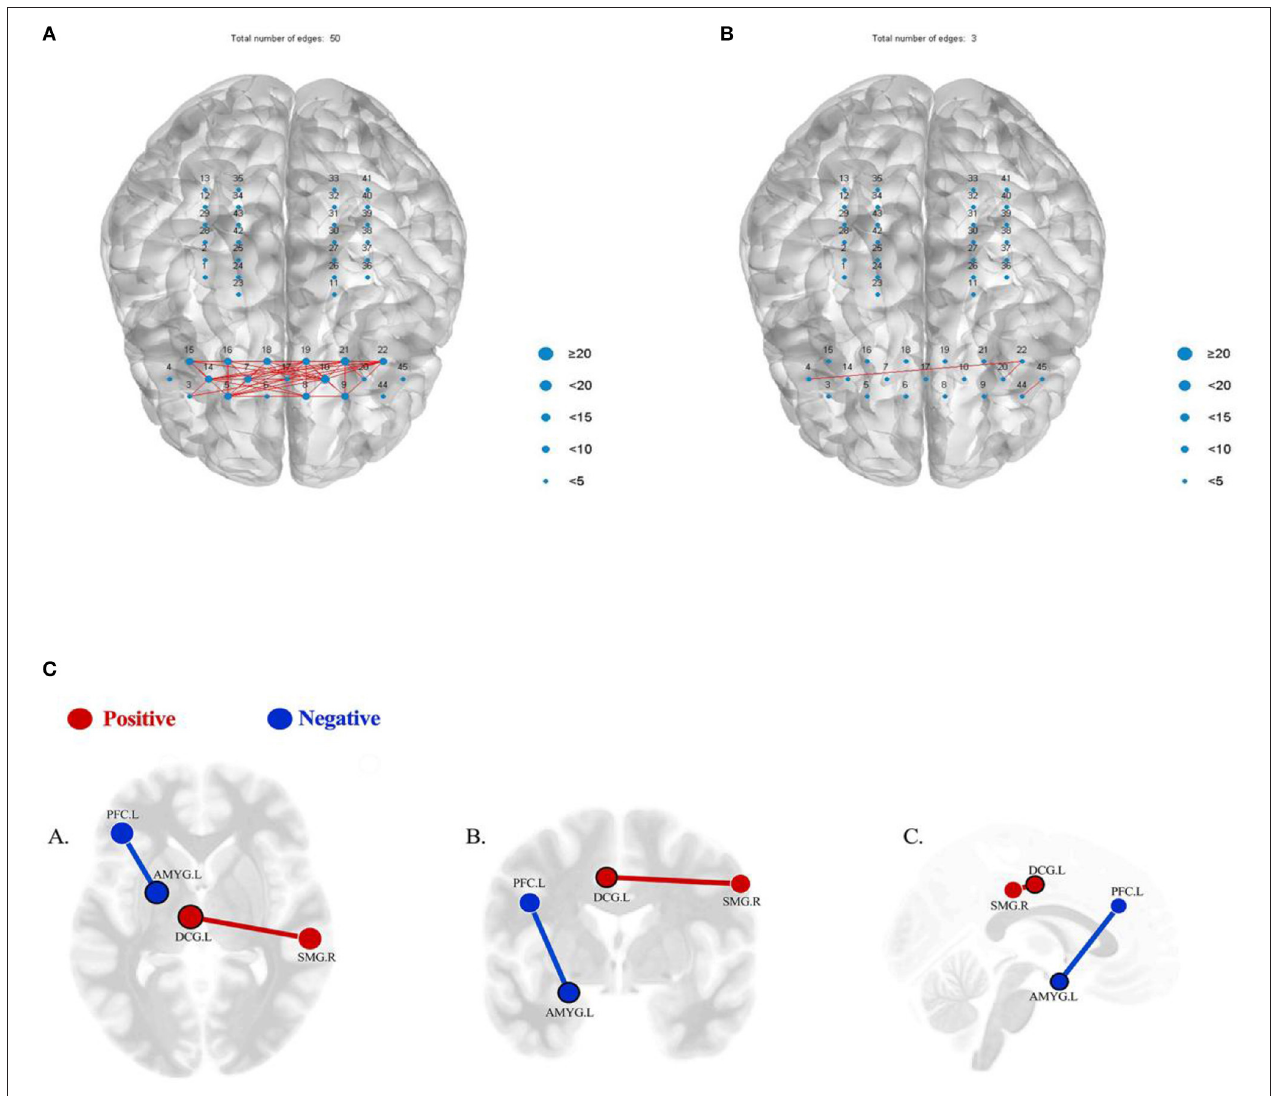
FIGURE 3 | (A) When the similarity threshold is 0.8, the functional connection diagram between the prefrontal channels of the patient before the first intervention. (B) When the similarity threshold is 0.8, the functional connection diagram between the prefrontal channels immediately after the first intervention. (C) Results of seed-based functional connectivity before and after the treatment. Red/positive: the result showing a significant hypo-connectivity between AMYG.L and PFC.L ( p = 0.0391, FDR corrected), before the treatment > after the treatment; blue/negative: the result showing a significant hyper-connectivity between DCG.L and SMG.R ( p = 0.0262, FDR corrected), after the treatment > before the treatment ( p < 0.05, FDR corrected). (A) Axial view; (B) coronal view; (C) sagittal view. AMYG.L, left amygdala; PFC.L, left prefrontal cortex; DCG.L, left median cingulate and paracingulate gyri; SMG.R, right supramarginal